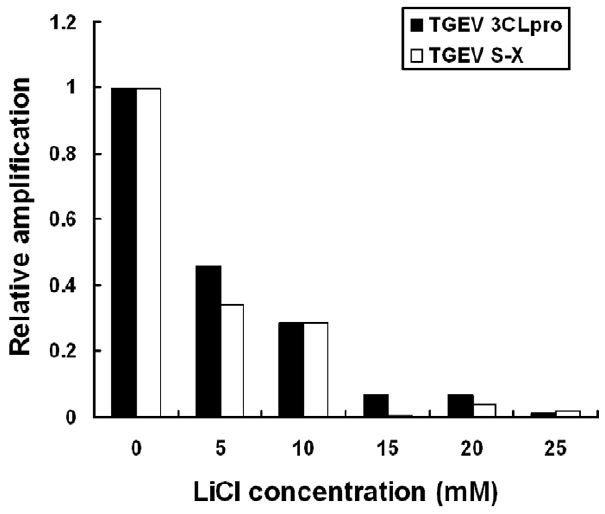
Figure 5. Quantitative measurement of TGEV 3CLpro and S-X gene. Viral RNA was extracted from cell lysates with or without LiCl treatment processed as described in M&M for real-time PCR. Reverse transcription was performed and the delta Ct value was measured at least in triplicate. The relative amplification of 3CLpro and TGEV-S-X in TGEV-infected cells was normalized to that of beta-actin and calculated using 2 2 gg Ct method. Displayed results are average of at least three independent